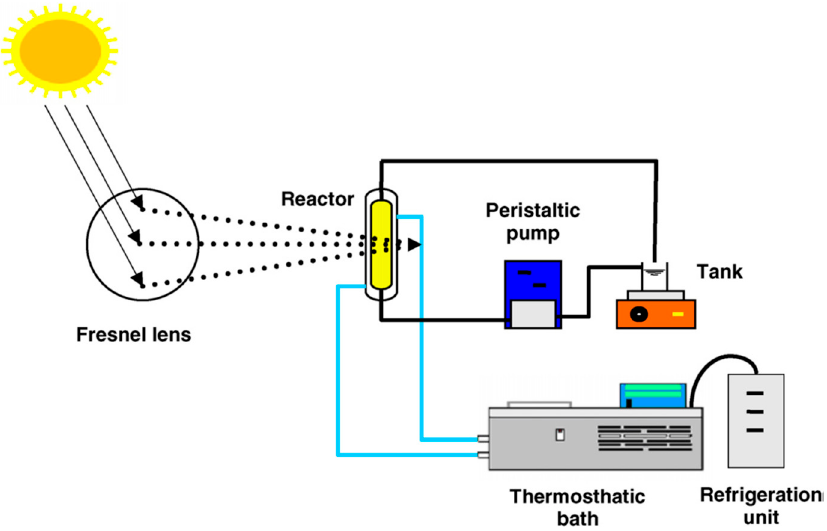
Figure 5. Fresnel lens transmitter concentrator scheme [60].